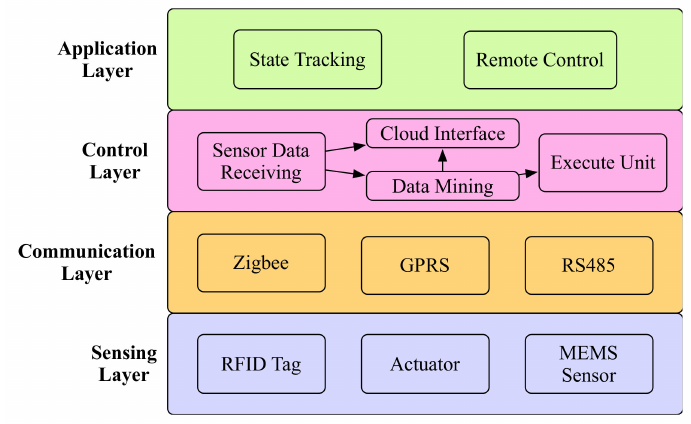
Figure 3. The microcontroller software